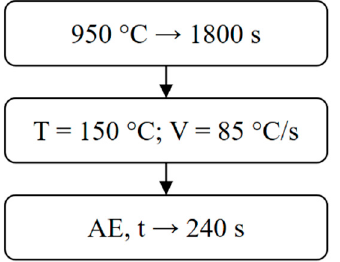
Figure 3. Flow diagram of the thermal treatment with marked recording time limits and acoustic emission emission (AE).